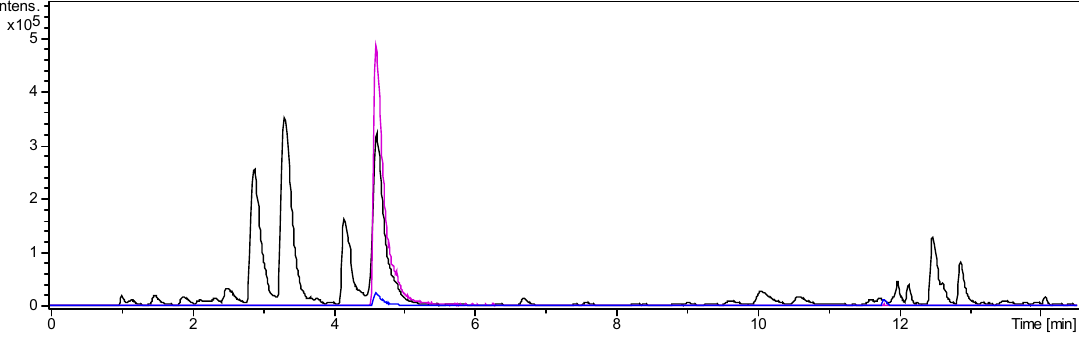
Figure 2. UHPLC /+ ESI-QqTOF-MS chromatogram of fraction 2: Base peak chromatogram of m / z 200–1000 (black), Extracted ion chromatogram of m / z 249 [M + 2H] 2 + (pink), Extracted ion Figure 2. UHPLC/+ESI-QqTOF-MS chromatogram of fraction 2: Base peak chromatogram of m/z 200– chromatogram of m / z 497 [M + H] + (blue). Enrichment of the target compound from ALOF to 1000 (black), Extracted ion chromatogram of m/z 249 [M + 2H] 2+ (pink), Extracted ion chromatogram fraction 2 was of m/z 497 [M + H] + (blue). Enrichment of the target compound from ALOF to fraction 2 was 10-fold.